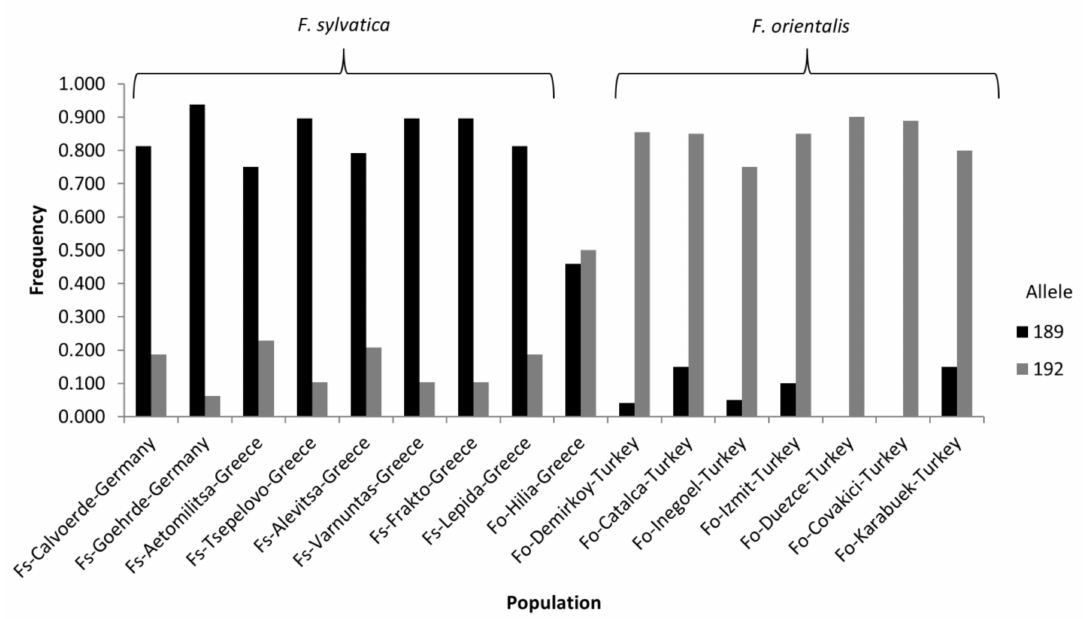
Figure 2. Frequencies of alleles 189 and 192 of locus Fs_C6785 for the di ff erent